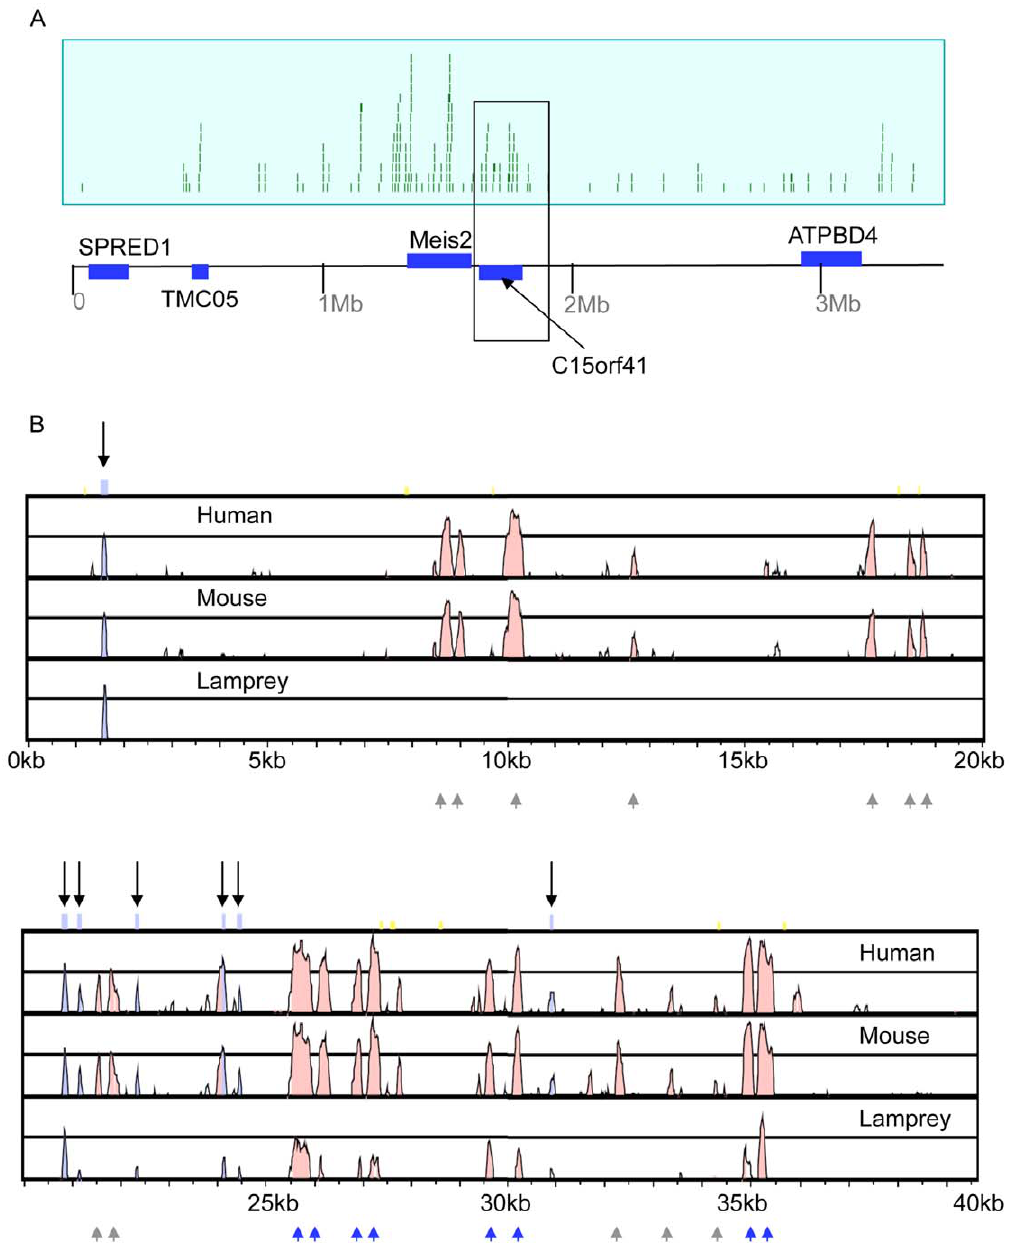
Figure 1. Conservation of non-coding sequences across the Meis2/c15orf41 locus in vertebrates. (A) Plot of non-coding sequence conservation between mammals and fish across a 3.5 Mb region of human chromosome 15q14, encompassing the Meis2 and c15orf41 genes. Each vertical bar within the blue panel represents a CNE. (B) MLAGAN alignment of the c15orf41 locus enclosed by rectangle in (A). Human (Hu), mouse (Mu) and lamprey (La) genomic regions are aligned with the orthologous reigon in the Fugu genome. Exons are annotated and represented by mauve peaks (black arrows) and are detectable in all species. Pink peaks represent non-coding conservation. A number of these are conserved in lamprey (blue arrowheads) but a number are also absent (grey arrowheads).